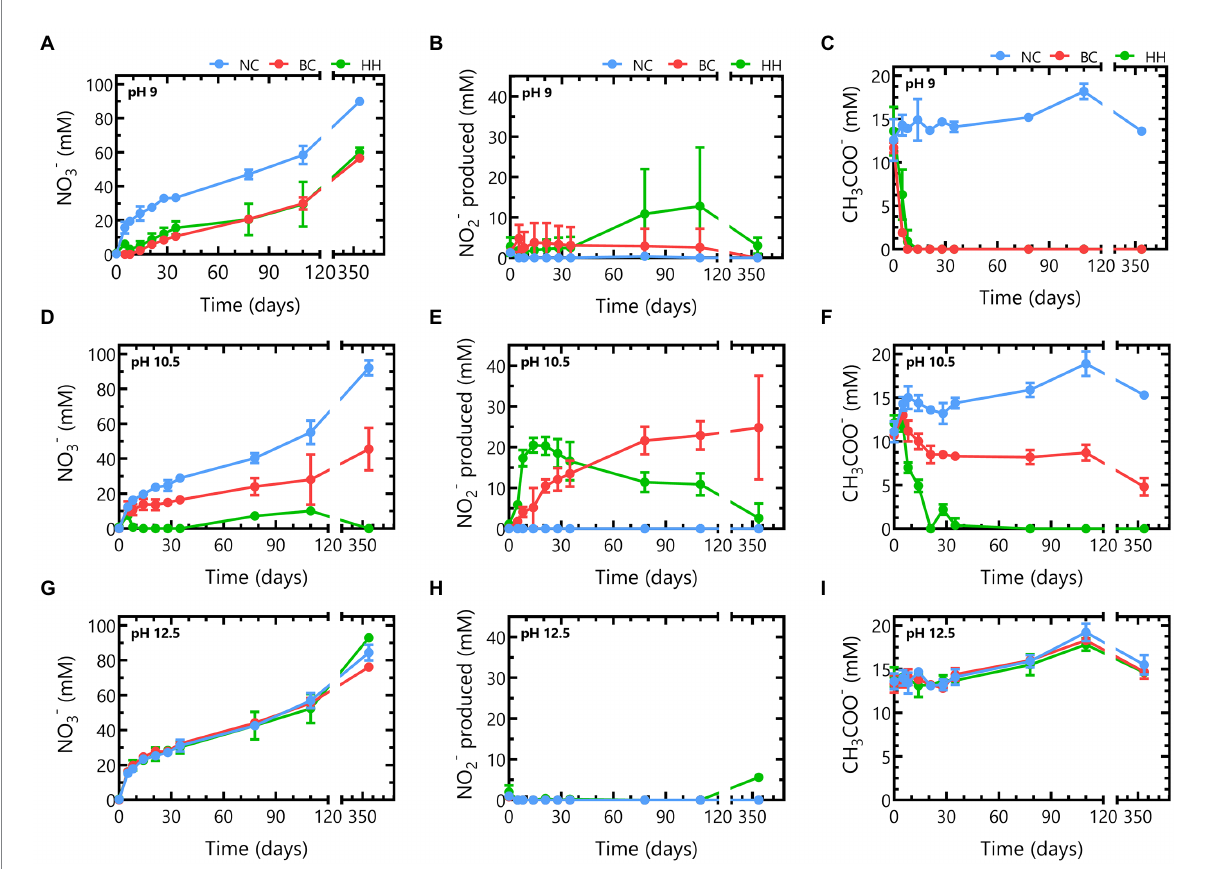
FIGURE 3 Nitrate ( A,D,G ), nitrite ( B,E,H ) and acetate ( C,F,I ) concentrations in abiotic samples (blue), samples inoculated with Boom Clay borehole water (red) or samples inoculated with Harpur Hill sediment (green) during 356 days of incubation in the presence of thermally aged